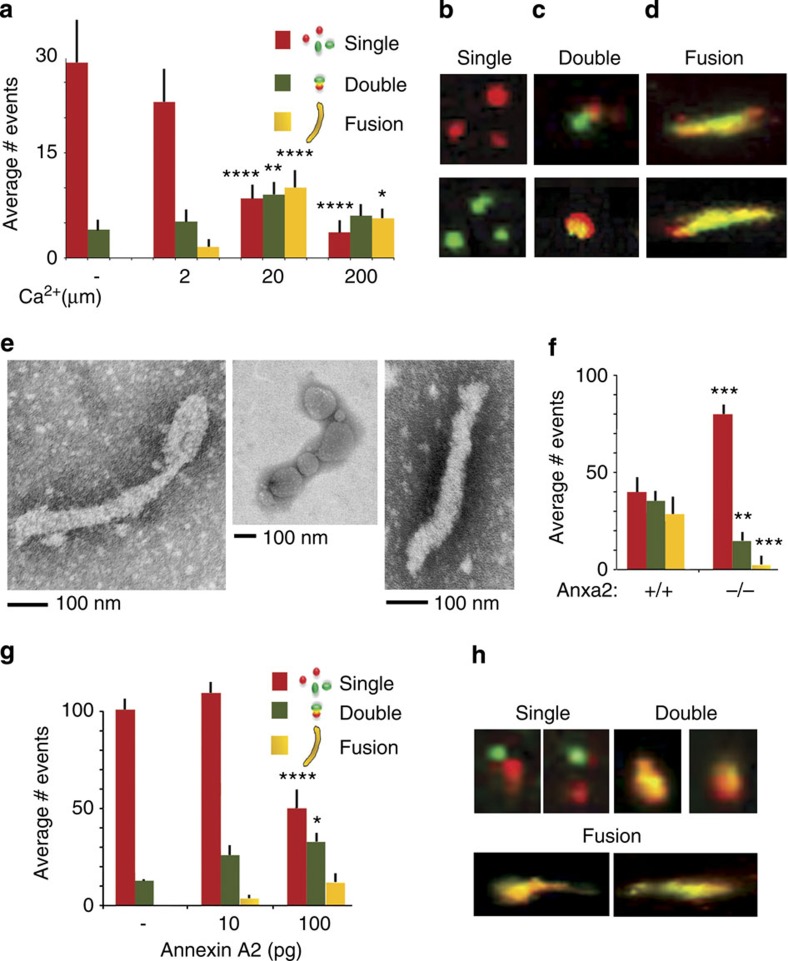
Annexin A2 is required for homotypic Atg16L+ vesicle fusion.(a–d) Analysis of Atg16L+/annexin A2+ vesicles fusion events at different Ca2+ concentrations; Atg16L+/annexin A2+ vesicles were sorted with Alexa-488 or Texas-Red-conjugated antibody to obtain mixed colour-positive vesicles. In vitro fusion was analysed at different Ca2+ concentrations. Single vesicles refer to structures as depicted in b; double vesicles refer to structures as depicted in c and multiple fusion refers to structures as depicted in d; the mean and s.e. were calculated from n>300 events. *P<0.05; **P<0.01; ****P<0.0001. (e) Ultrastructural analysis of phagophore-like structures derived from the in vitro fusion of Atg16L+/annexin A2+ vesicles. (f) Quantification of fusion events among Atg16L+ vesicles sorted from Anxa2+/+ and Anxa2−/− DCs; the mean and s.e. were calculated from n>300 events. **P<0.01; ***P<0.001. (g,h) Quantification of fusion events among Atg-16L vesicles sorted from Anxa2+/+ and Anxa2−/− DCs, plus or minus reconstitution with annexin A2; the mean and s.e. were calculated from n>300 events. *P<0.05; ****P<0.0001 (all unpaired two-tailed Student’s t-test).